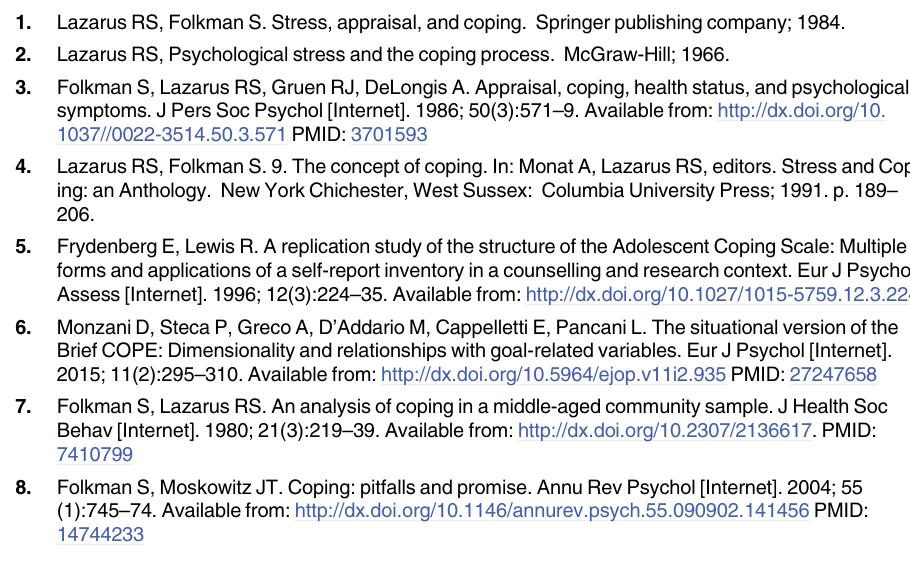
S1 Table. Original Brief-COPE items vs. I-Brief-COPE